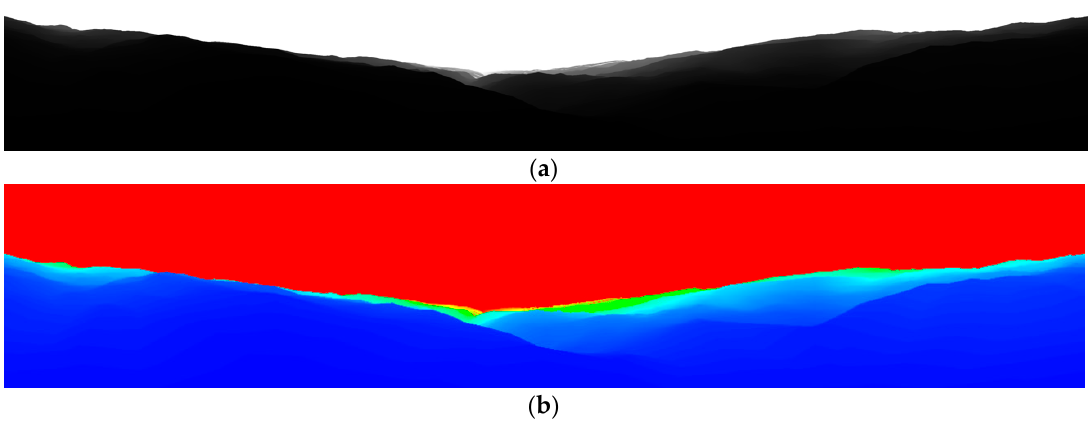
Figure 19. 360 ◦ rendering generated from a DEM sampled point. ( a ) Original greyscale image. The leftmost end of the image is in the north direction, which is unfolded in a clockwise direction. The middle of the picture is due south, and the far right is due north. The white part of the image is the sky, and the lower part shows the distance between the mountain and the observation point displayed with different grey levels. The closer the mountain is, the higher the grey value. The lower boundary of the white area is the skyline, and where the grey level of the lower half changes is the ridge line. ( b ) The pseudo color image was generated from the original greyscale image, which is convenient for manual observation and judgment.